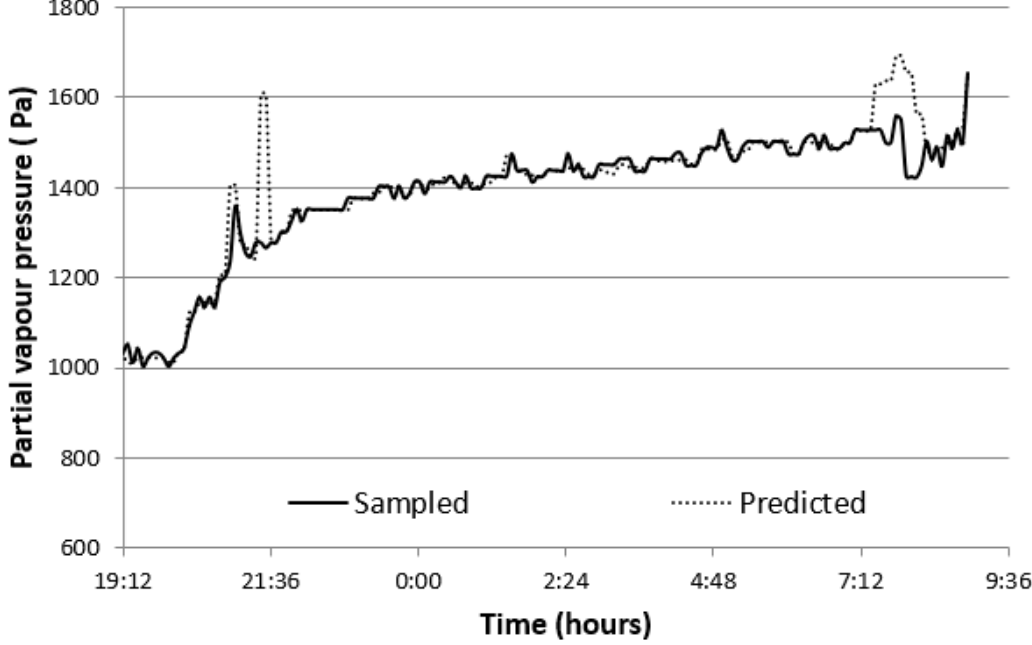
Figure 4. Example of sampled and predicted partial vapor pressure in the winter season.